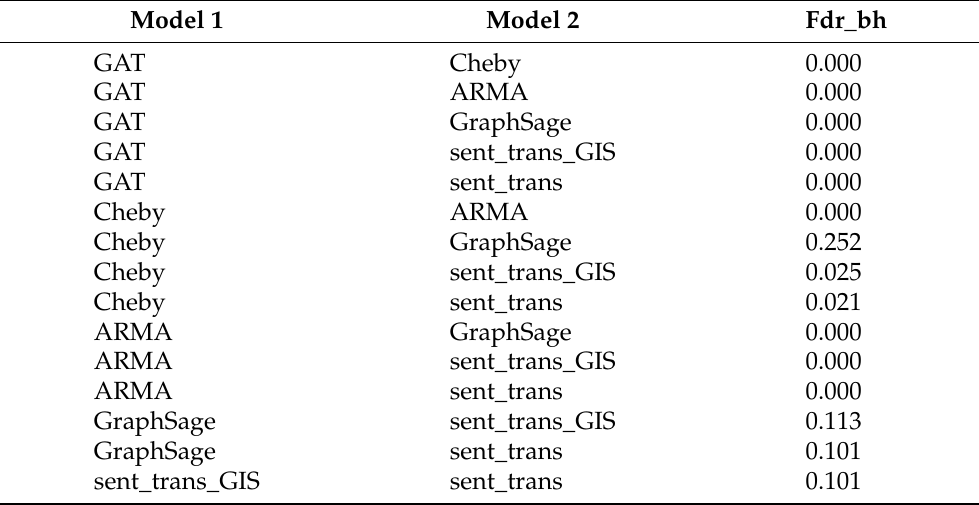
Table 1. Results of paired pairwise t